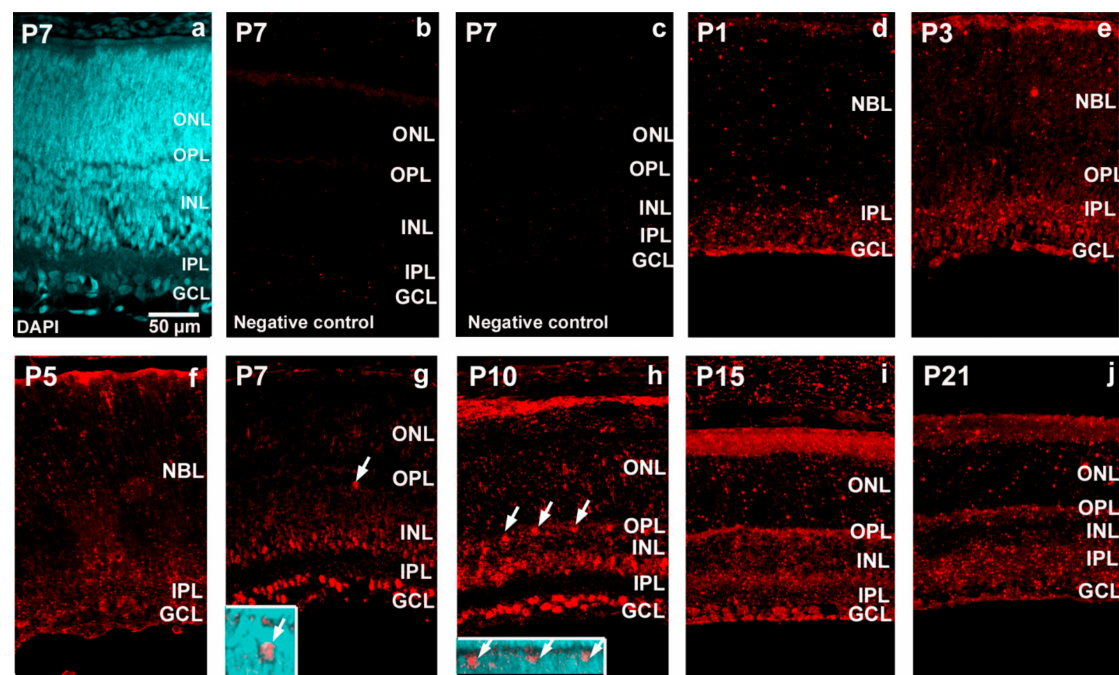
Figure 4. The cellular localization of miR-9 in the Wistar rat retina in the first 3 postnatal weeks by in situ hybridization (( d ) P1; ( e ) P3; ( f ) P5; ( g ) P7; ( h ) P10; ( i ) P15; ( j ) P21). The retina has been counterstained with 4 (cid:48) ,6-diamidino-2-phenylindole (DAPI) ( a ) and different controls ( b ) without anti-mir-9, or ( c ) without anti-digoxigenin (DIG)-horseradish peroxidase are presented. Insert images demonstrate the overlap of mir-9 in situ hybridization (ISH) with DAPI. Arrows indicate horizontal cells at P7 and P10. The scale bar represents 50 µ m. GCL, ganglion cell layer; IPL, inner plexiform layer; NBL, neuroblast layer; INL, inner nuclear layer; OPL, outer plexiform layer; ONL, outer nuclear